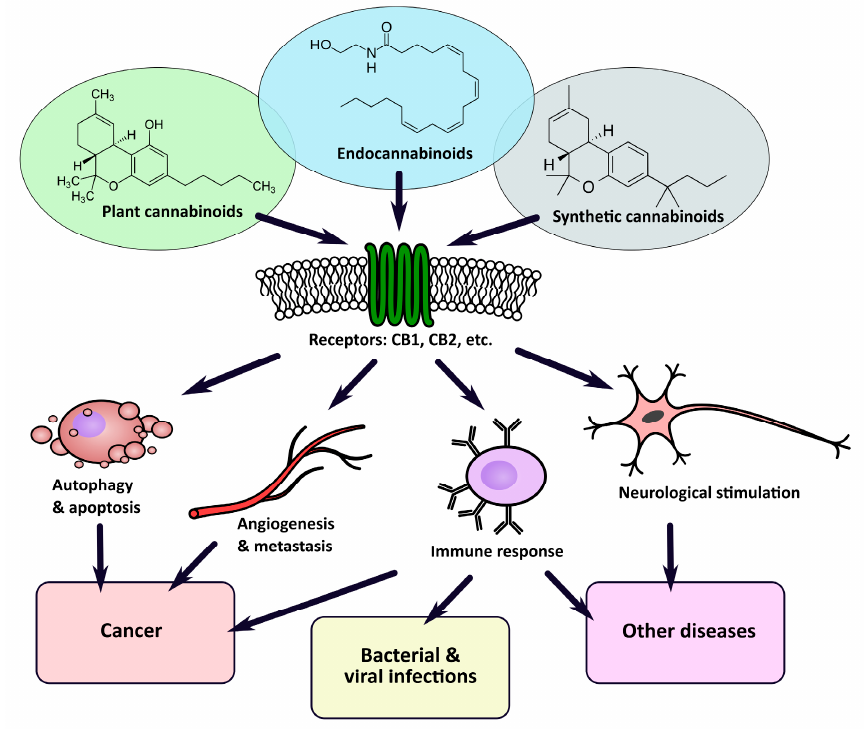
Figure 1. The involvement of the endocannabinoid system in a variety of modulatory processes makes it a promising target in the therapy of many conditions.